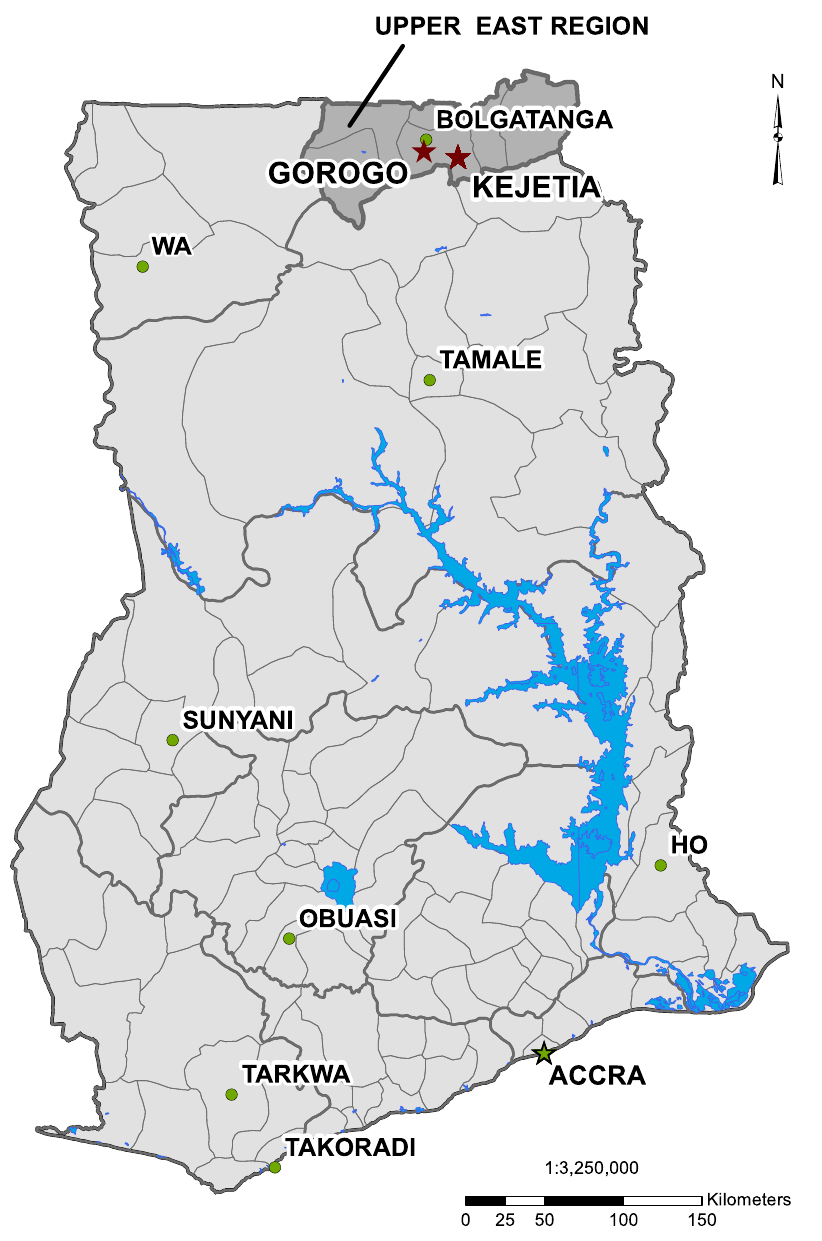
Figure 1. Map of Ghana indicating Kejetia and Gorogo (two red stars), the two research communities, and the municipal capital, Bolgatanga (green circle), in the Upper East Region. (Map produced from data provided by the National Renewable Energy Laboratory [NREL], by Mozhgon Rajaee, June 2012